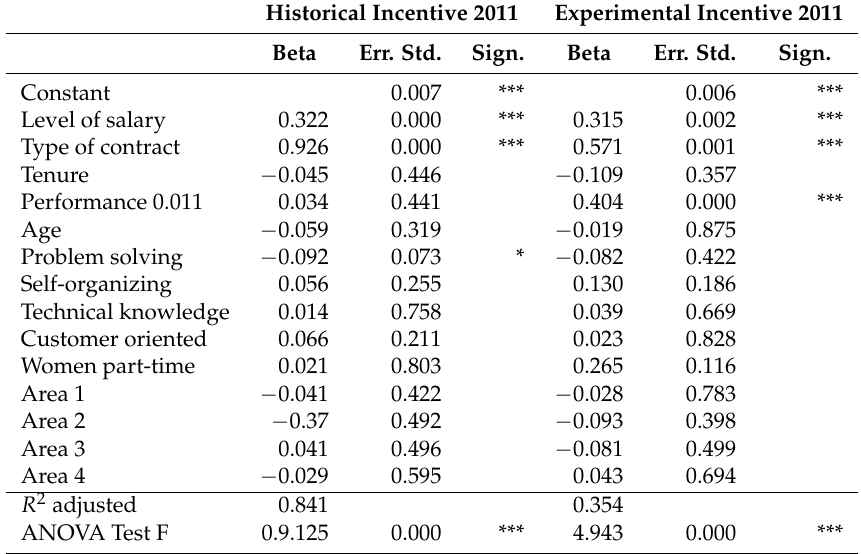
Table A1. Results of linear regressions described in Equations (4) and (5) considering all the interactive variables described in Cainarca et al. (2019). * Significant at the 10%. *** Significant at the 1%.